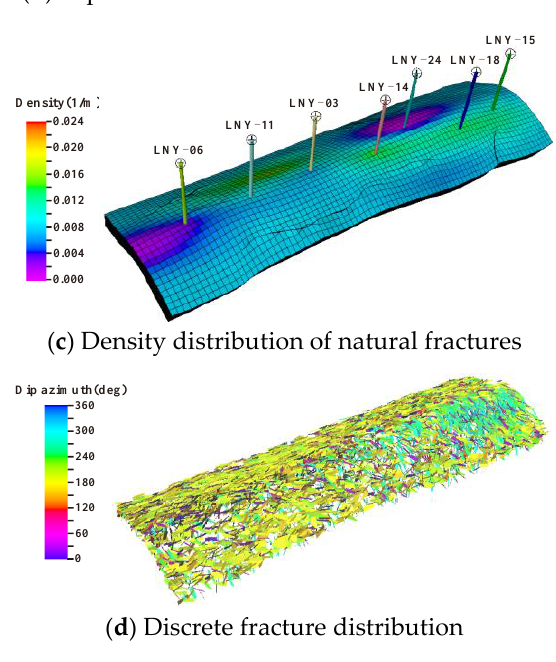
Figure 8. Natural fractures properties of modeling.